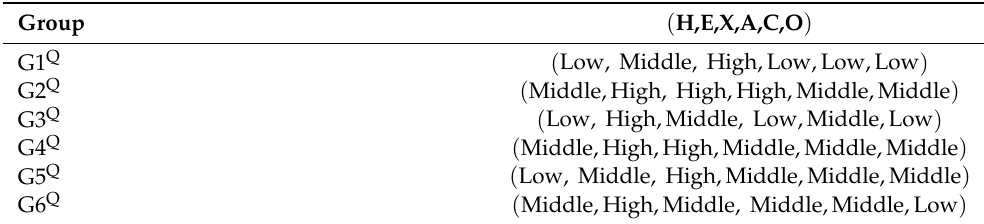
Figure 6. HEXACO scores of six groups, G1–G6, shown in radar charts. Table 2 shows players’ fuzzy descriptions (honesty/humility, emotionality, Table 2. Players’ personality orientation for each HEXACO dimension. extraversion, agreeableness, conscientiousness, and openness to experience) in the six groups. Group